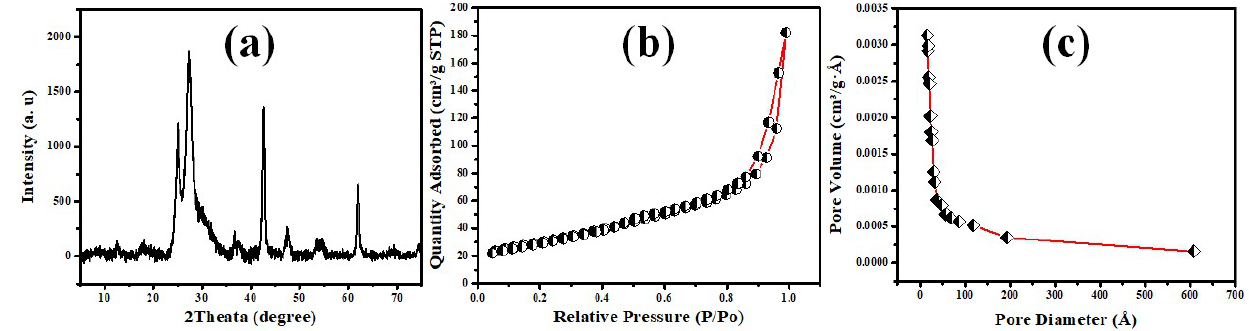
Figure 3. ( a ) XRD pattern, ( b ) the hysteresis loop, and ( c ) pore diameter distribution results of MgTiO 3 @g-C 3 N 4 nanohybrid. MgTiO 3 @g-C 3 N 4